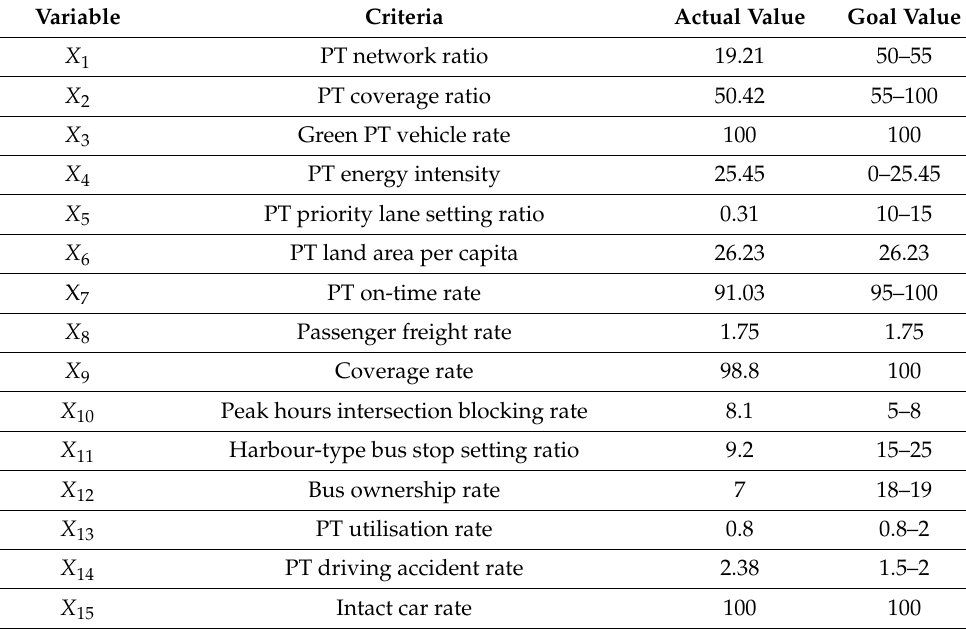
Table 2. Cockburn’s actual and goal values for decision